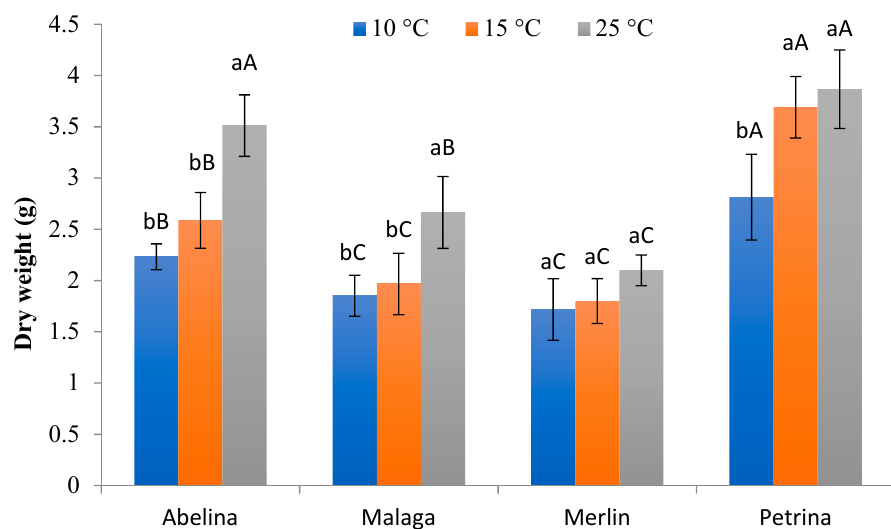
Figure 6. Dry weight of aboveground parts in four soybean cultivars grown for the first seven weeks from the seeds germinated for 48 h at different temperatures. Values represent means ( n = 20) ± SE. The values for each cultivar followed by the same lowercase letter do not differ significantly, while means for the same temperature marked with the same uppercase letter do not differ significantly according to Duncan’s multiple range test ( p < 0.05).